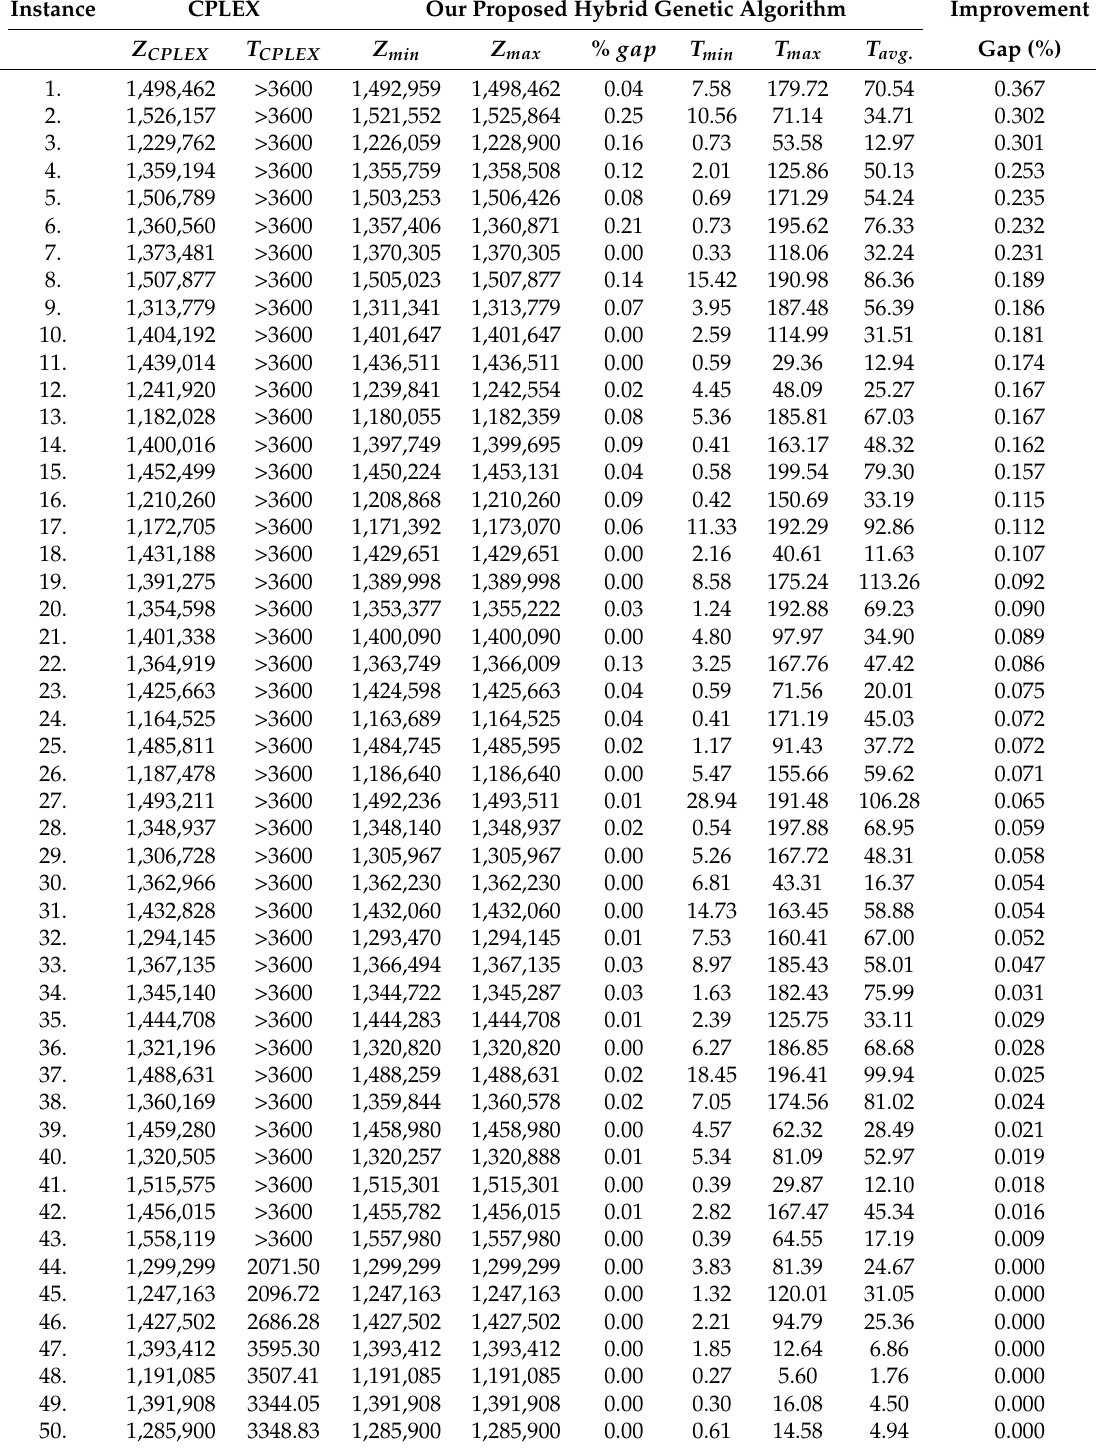
Table 3. Computational results achieved in the case of large sized